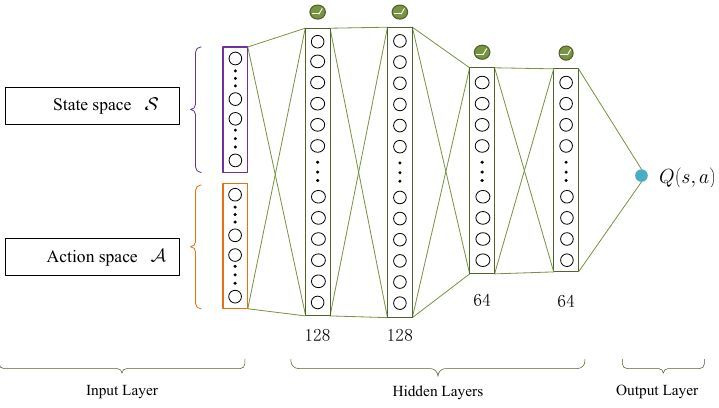
Figure 2. The actor network architecture with four hidden layers.